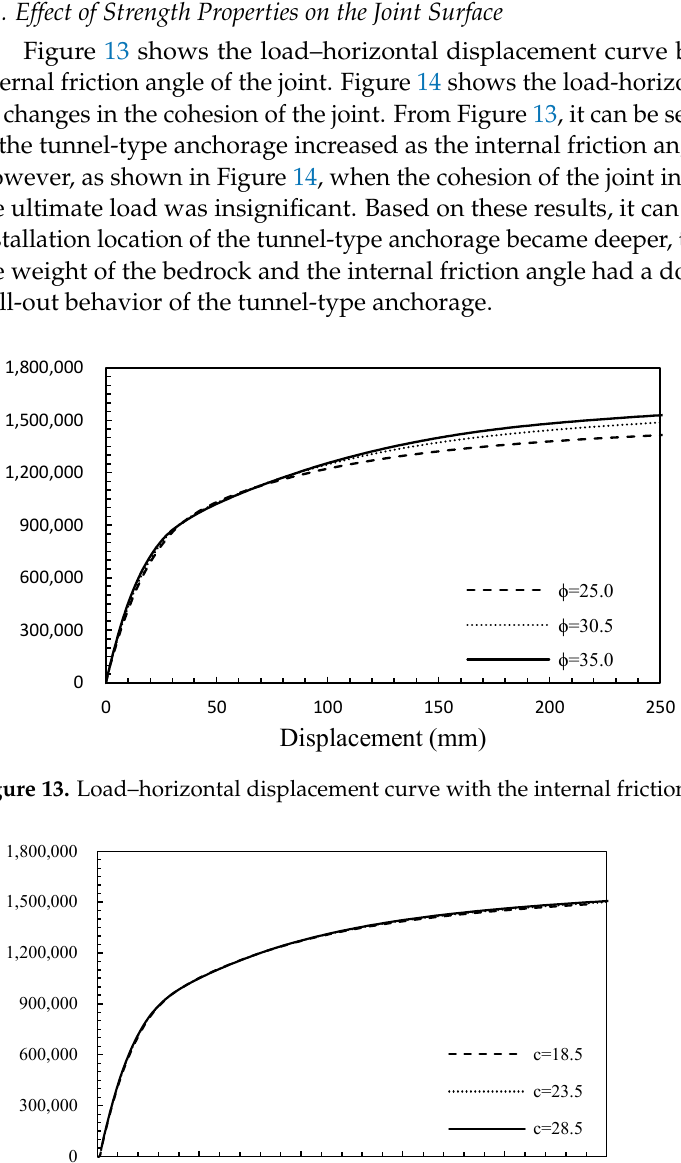
Figure 12. Load–horizontal displacement curve with joint spacing.